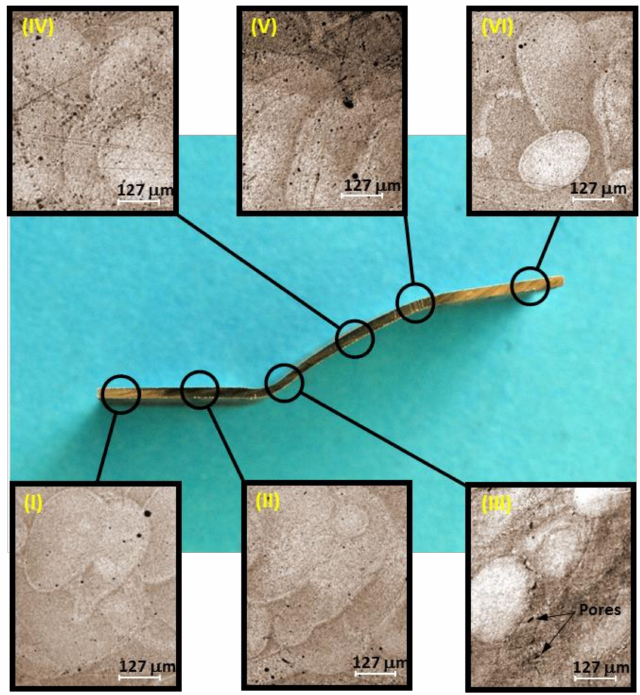
Figure 12. Microstructural evolution of the SPIFed AlSi10Mg